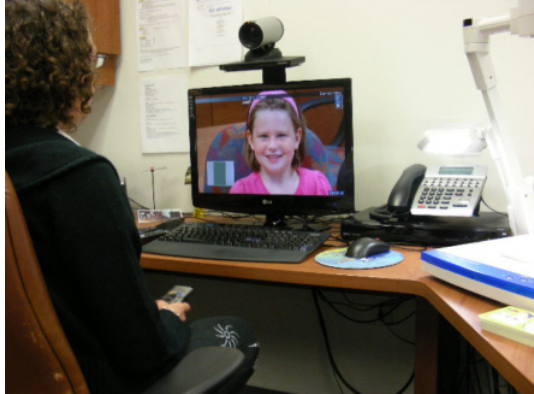
Figure 1. Image of client with document